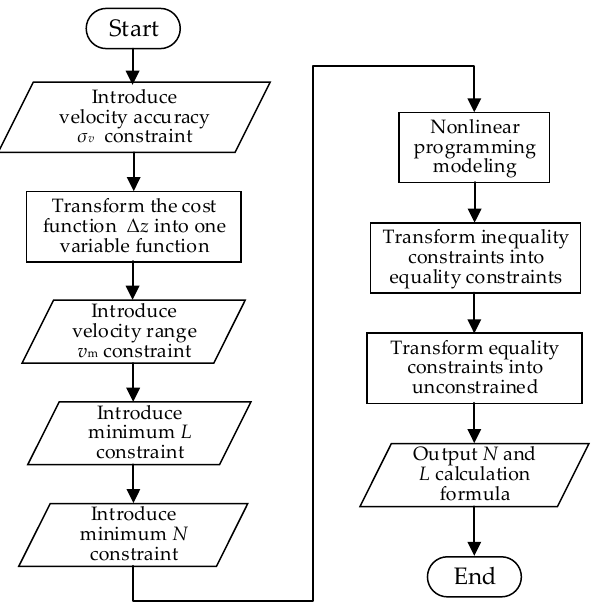
Figure 5. Flow chart of the WSAP method.